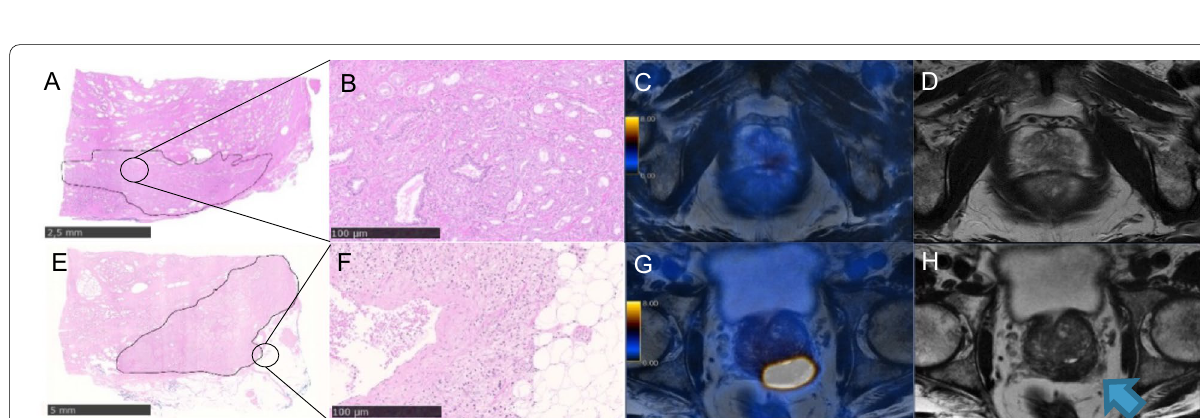
Fig. 4 [ 68 Ga]PSMA-PET/MRI and mpMRI images of a 69-year-old patient with PSA of 3.7 ng/ml that subsequently underwent radical prostatectomy (ISUP 3). a , b Histopathology slide negative for EPD with ( a ) overview (bar 2.5 mm) and ( b ) magnification (bar 100 µm) showing PCa on = = the right-posterior mid-gland prostate; c corresponding axial [ 68 Ga]PSMA PET/MRI with SUV max of 4.7, PSMA tot of 2.0 g/ml, and PSMA vol of 0.485cm3; d axial T2-weighted mpMRI showing an LCC of 6 mm. e – h [ 68 Ga]PSMA-PET/MRI images of a 64-year-old patient with PSA of 11 ng/ ml that subsequently underwent radical prostatectomy (ISUP 5). e – f Histopathology slide positive for EPD with ( e ) overview (bar 5 mm) and ( f ) = magnification (bar 100 µm), showing PCa on the posterior part of the prostatic base (blue arrow); g corresponding axial [ 68 Ga]PSMA PET/MRI with = SUV max of 37.1, PSMA tot of 201.2 g/ml, and PSMA vol of 18.6cm3; h axial T2-weighted MRI showing an LCC of 41